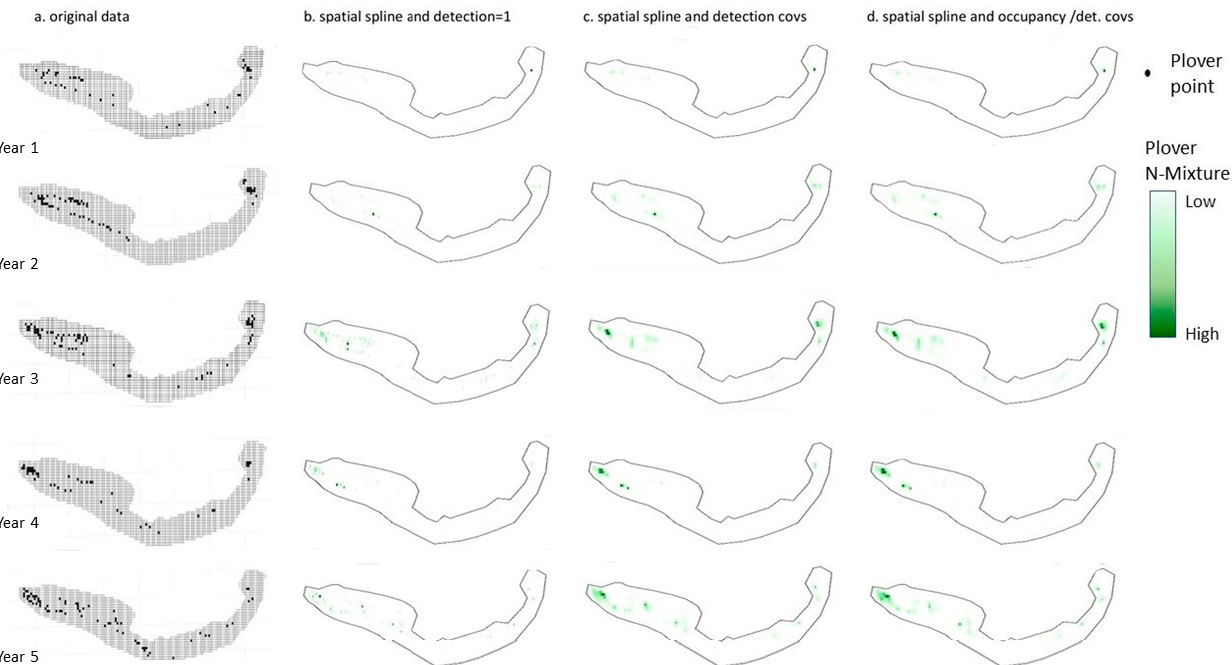
Figure 4. Piping plover N -mixture model with the spatial spline maps of hotspot distribution areas. Values range from 0 (white) to the max values from Table 4 (dark green). Table 4. Model estimates for piping plover total N for Whiskey Island, reporting the mean and 97.5% con fi dence interval (CI).